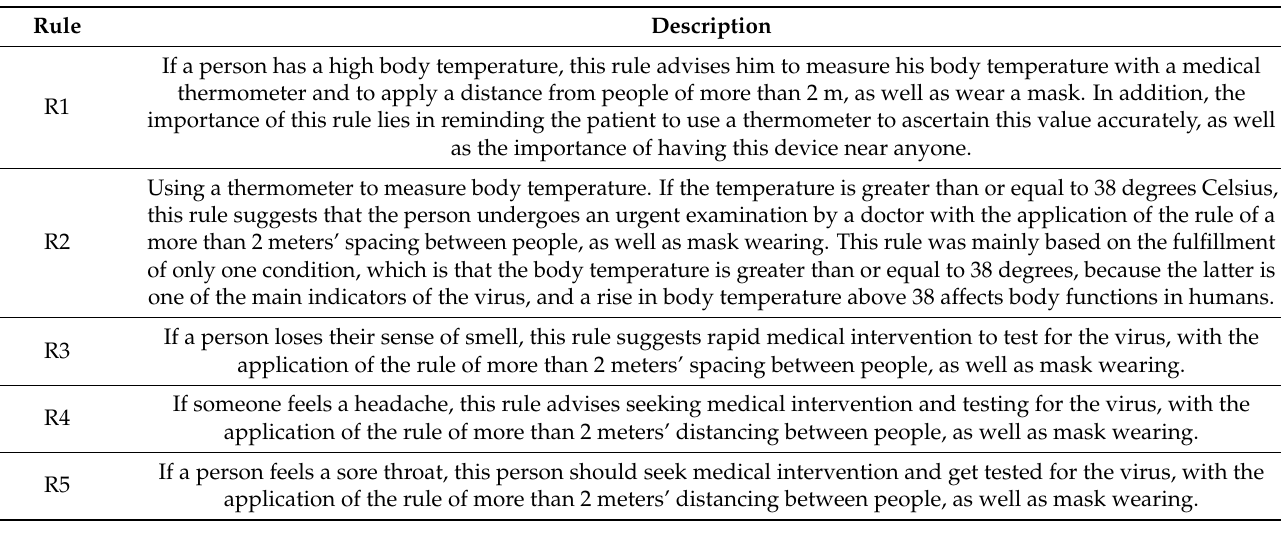
Table 5. Examples of rules for the